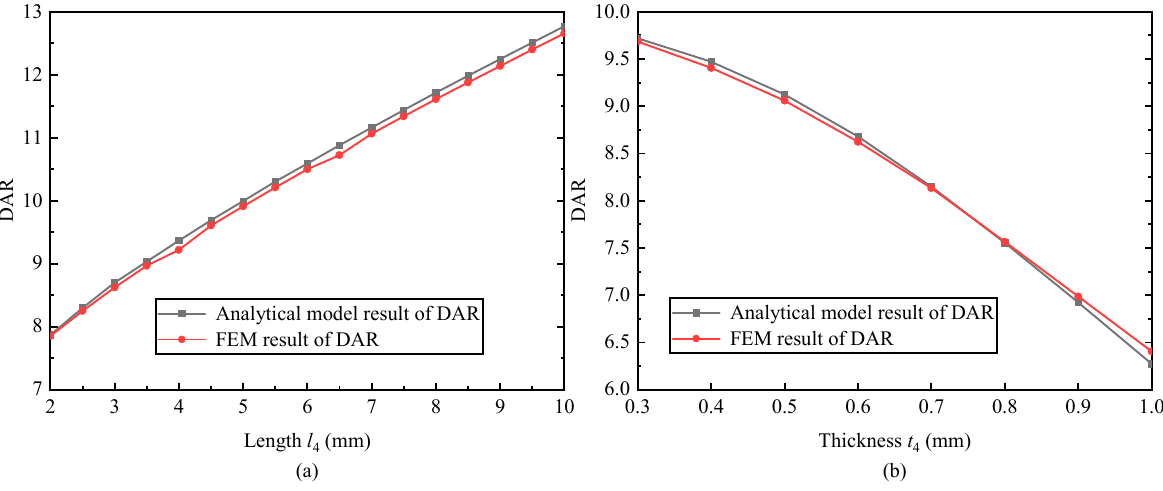
Figure 9. The changes in DAR with the flexure hinge varied. ( a ) The flexure hinge length l 4 . ( b ) The flexure hinge thickness t 4